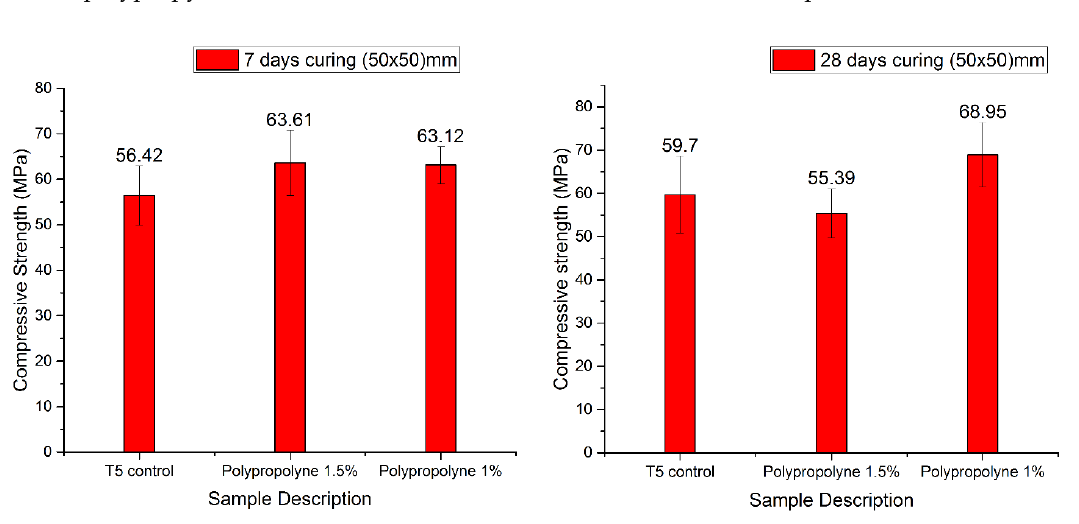
Figure 17. Compressive strength test results for manual mortar mix after 7-day and 28-day curing (the values denote the actual strengths).